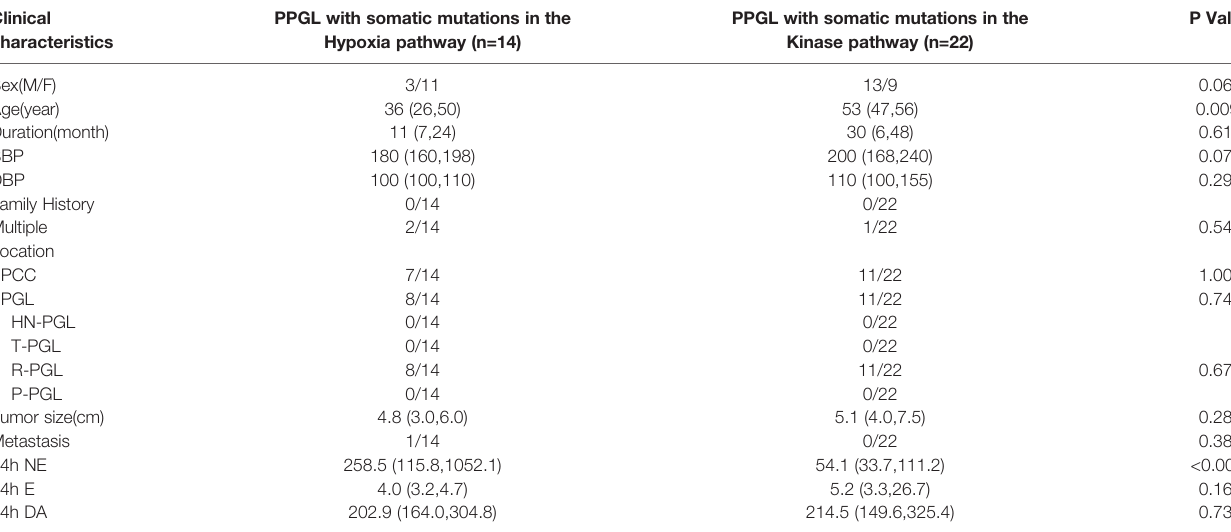
TABLE 4 | Comparison of clinical characteristics of PPGL with somatic mutations in different pathways. Clinical characteristics